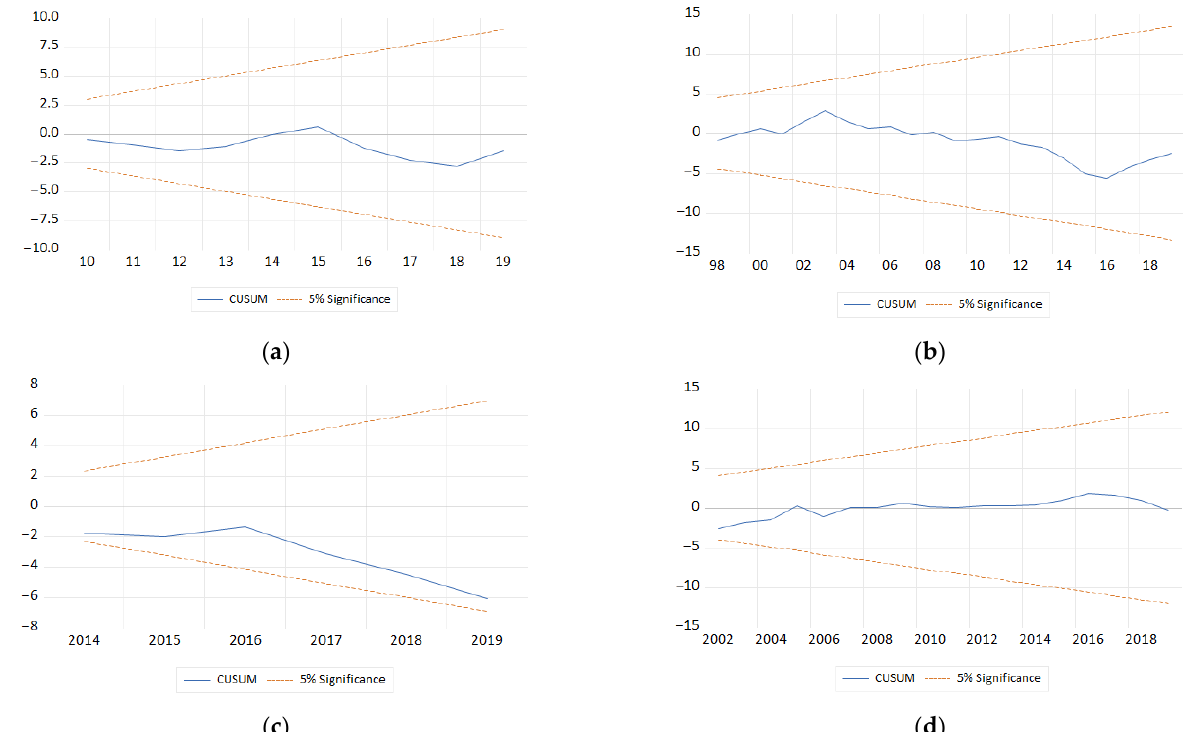
Figure A4. Slovak Republic ( a ) Model 1 (dep. variable CO 2 ). ( b ) Model 2 (dep. variable EC). ( c ) Model 3 (dep. variable GDP). ( d ) Model 4 (dep. variable FRT).